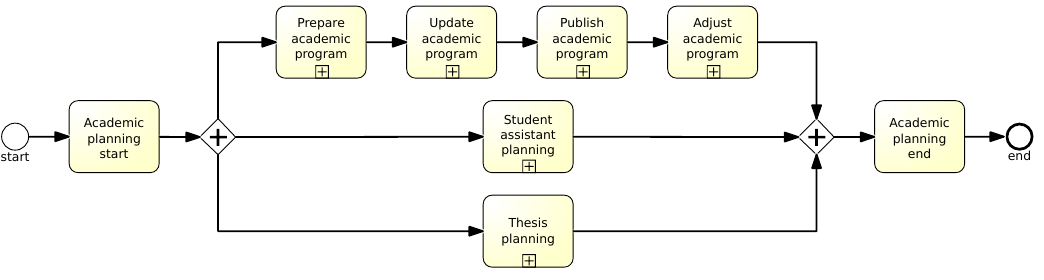
Figure 10. General model of the academic planning process of a university. It includes parallel flows that contain